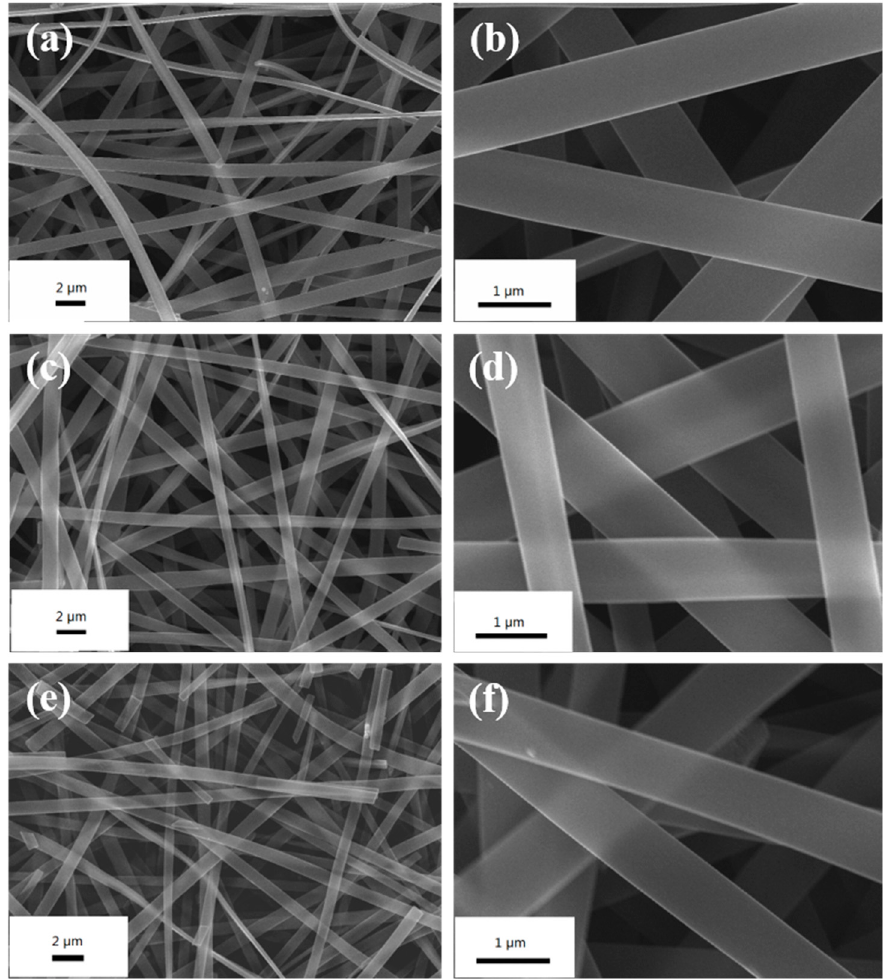
Figure 1. SEM images of ( a,b ) MPCNF-650, ( c,d ) MPCNF-750 and ( e,f ) MPCNF-800.